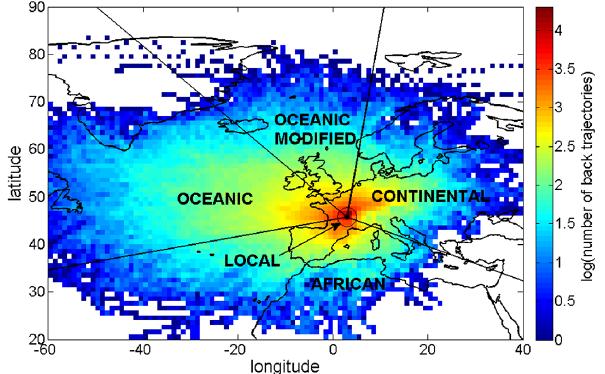
Figure 8. Back trajectories of air masses measured at the Puy de Dôme over the measurement period September 2008–December 2012, calculated from the HYSPLIT model.